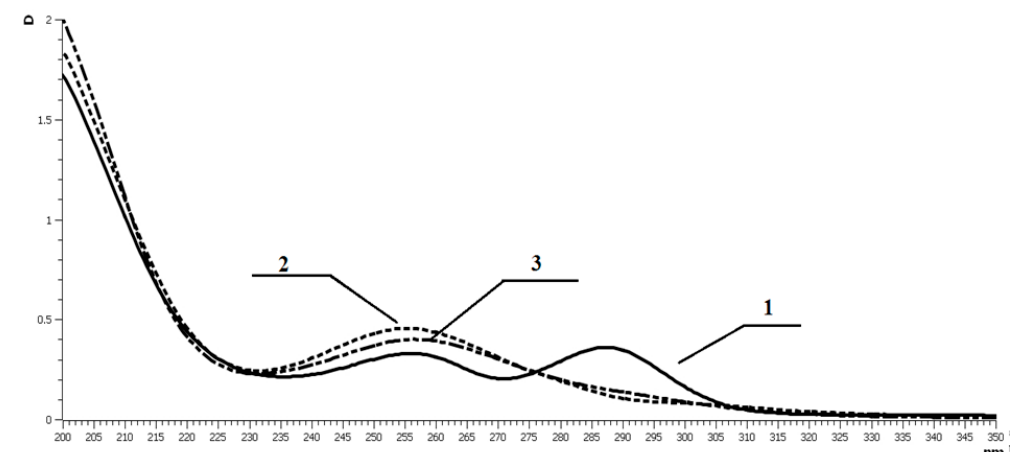
Figure 6. Study of complexation of VP–VDTC ( M r = 12 × 10 3 Da, 18 mol.% of VDTC) with gallium and indium by UV spectroscopy in aqueous solutions. 1—initial copolymer; 2—MPC with indium; 3—MPC with gallium. Concentration of VP–VDTC is 1 × 10 − 4 mol/L.